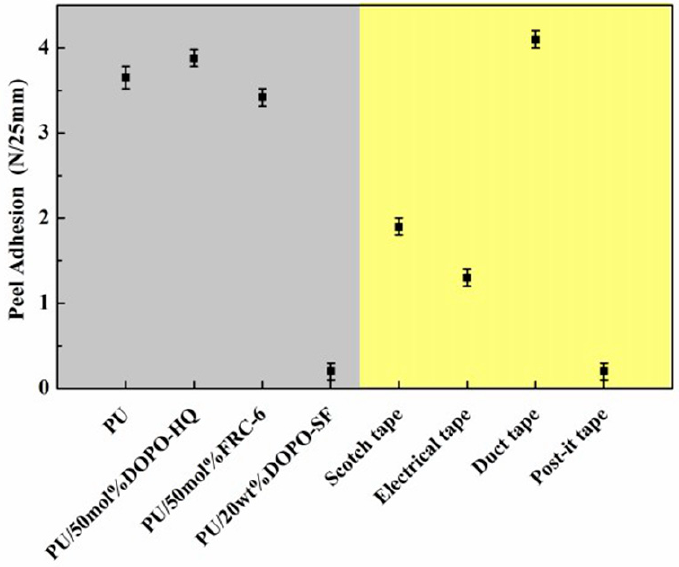
Figure 4. The adhesive properties of I-FRPU-PSA tapes and commercial PSA tapes. Table 6. Adhesive properties of FRPU-PSA and commercial PSA tapes.